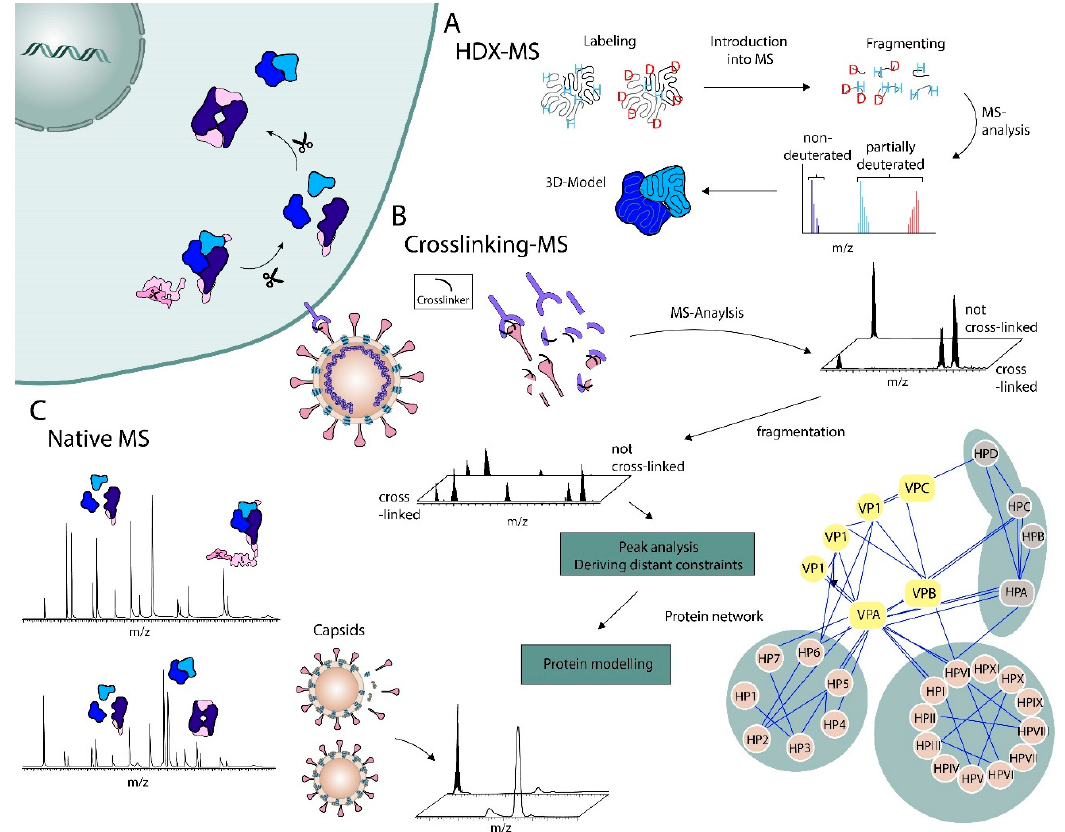
Figure 1. Structural mass spectrometry (MS) for RNA viruses. All depicted approaches can be conducted as top-down MS whereby exchange of hydrogen to deuterium mass spectrometry (HDX-MS) ( A ) and crosslinking mass spectrometry (XL- MS) ( B ) are currently mainly used as bottom-up techniques. For HDX-MS, the workflow starts with labeling of the natively folded protein by exchanging hydrogens to deuterium. The labeled protein is either fragmented or digested to the peptide level. Subsequent MS analyses reveal non-deuterated and partially deuterated peptides leading to constraints for a 3D model. A similar principle is used in XL-MS experiments ( B ). First, the protein complex is labeled, which can be done in both ways, in vitro and In Vivo, then the sample is fragmented or digested. Distant constraints can be deduced from every successful XL-MS experiment bringing up valuable information for computational modeling and the proposition of a structural model. In Vivo XL-MS offers the identification of a protein interaction network (bottom right) realizing the ability to unravel important virus-host association. ( C ) Native MS can determine stoichiometries of protein complexes (blue shaded) or measure whole virus capsids.